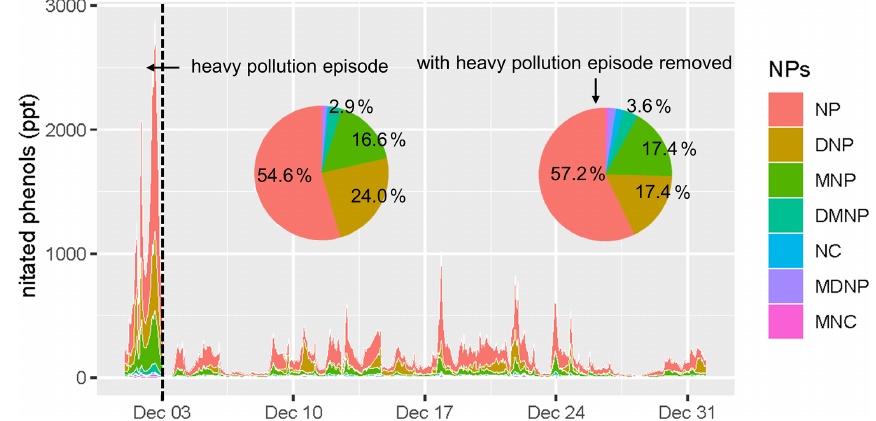
Figure 2. Time series (local time) and compositions of nitrated phenols (NPs) during the heavy pollution episode (1 and 2 December) and with the heavy pollution episode removed (3 to 31 December). NPs in the legend referred to nitrophenol (NP), dinitrophenol (DNP), methyl-nitrophenol (MNP), dimethyl-nitrophenol (DMNP), nitrocatechol (NC), methyl-dinitrophenol (MDNP), and methyl-nitrocatechol (MNC).